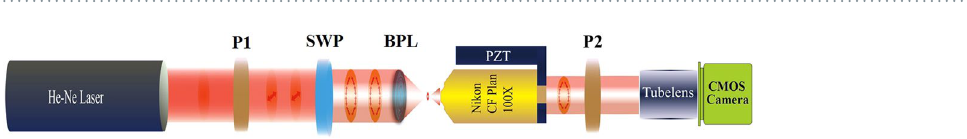
Figure 4. An SEM image of the super-oscillatory binary phase lens with diameter of 822 μ m, which consists of 292 Si 3 N 4 ring belts in the radial direction with smallest ring width of 400 nm.